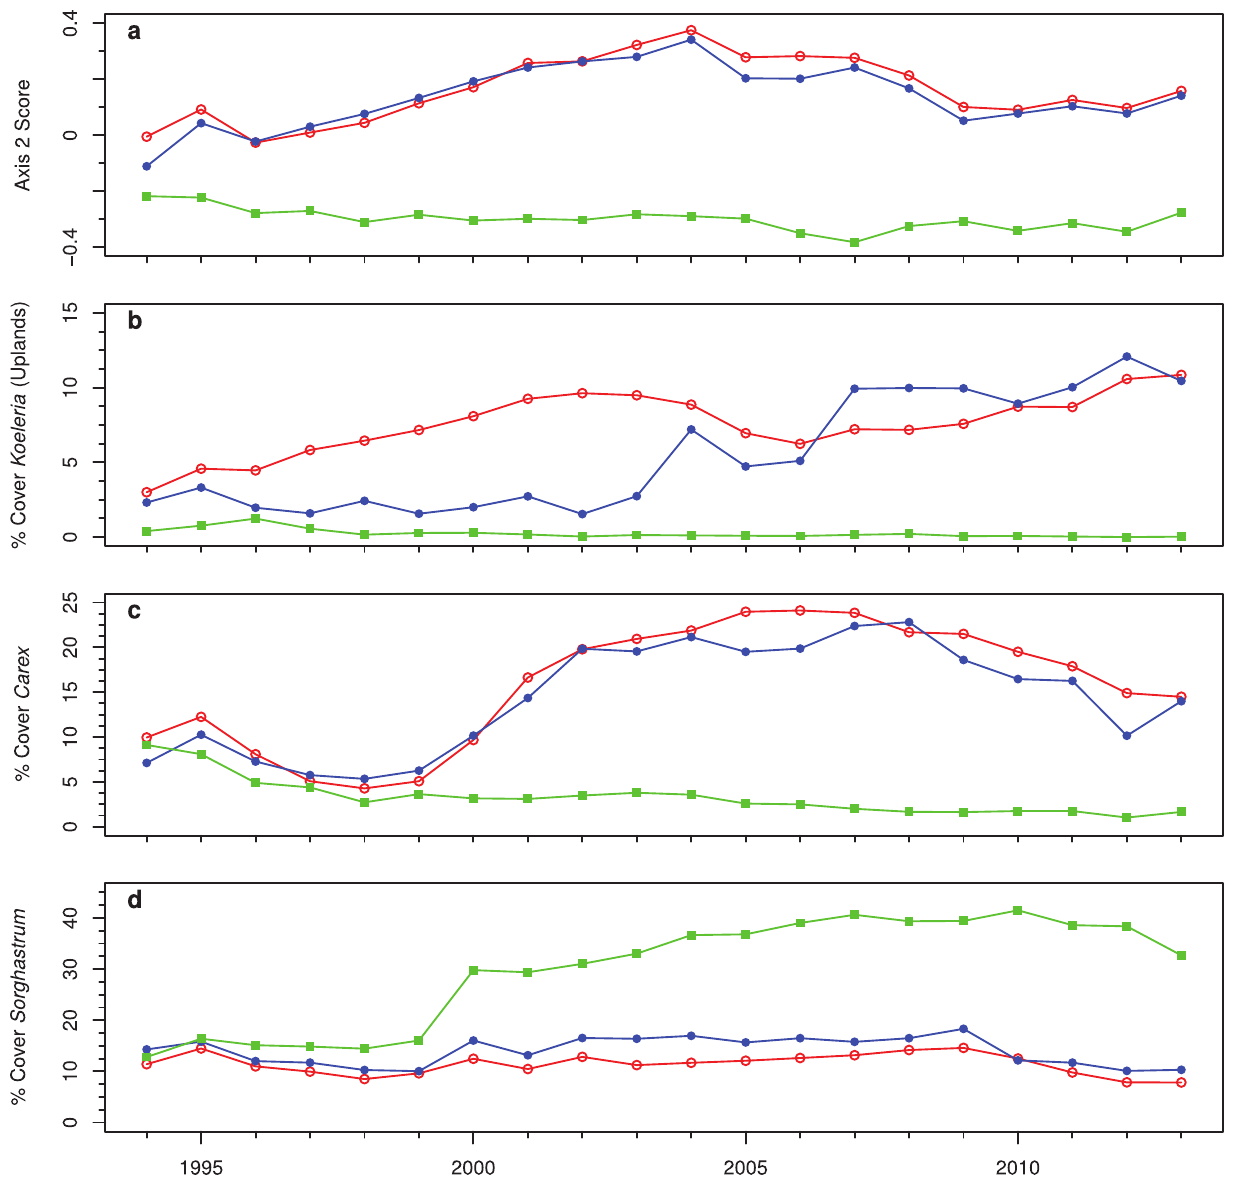
Figure 6. Changes from 1994–2013 of (a) NMDS axis 2 scores for all upland and lowland plots, and cover values of (b) Koeleria macrantha , (c) Carex spp., and (d) Sorghastrumnutans . Cover values were averaged for uplands and lowlands for a given burn treatment for all examples, except for Koeleria , which is shown for just uplands, since it was rarely found in lowlands.